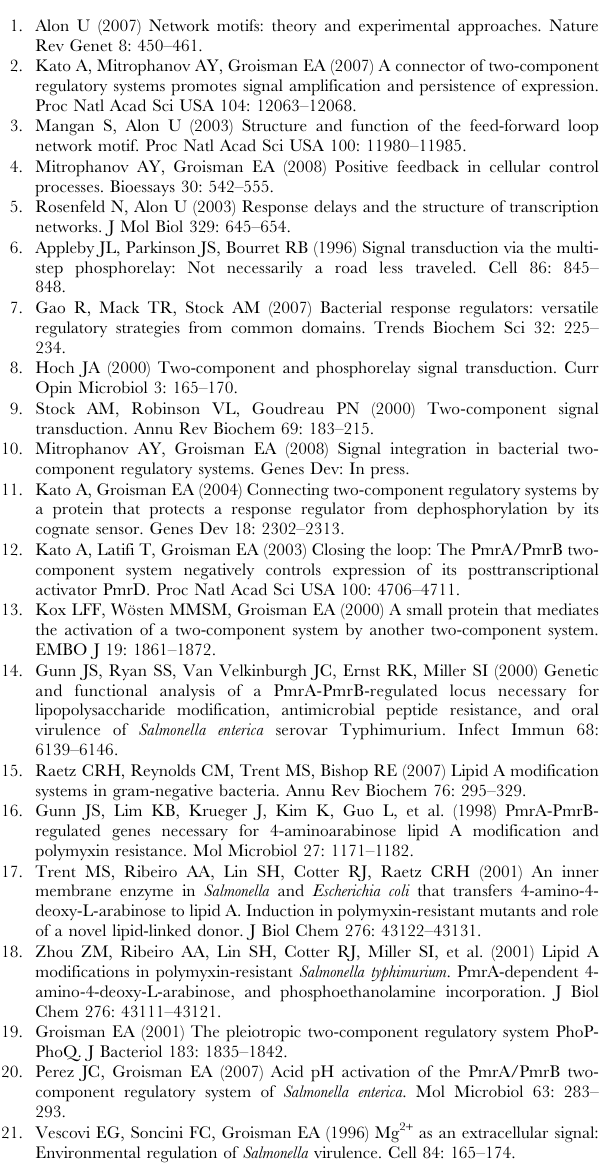
Table S1 List of strains and plasmids used in this study. Found at: doi:10.1371/journal.pgen.1000233.s007 (0.14 MB PDF) Table S2 Intervals used for model parameter sampling. The superscripts for the parameters are omitted, because the same intervals are used to sample the corresponding parameters for the FCL, FFL, and the direct regulation